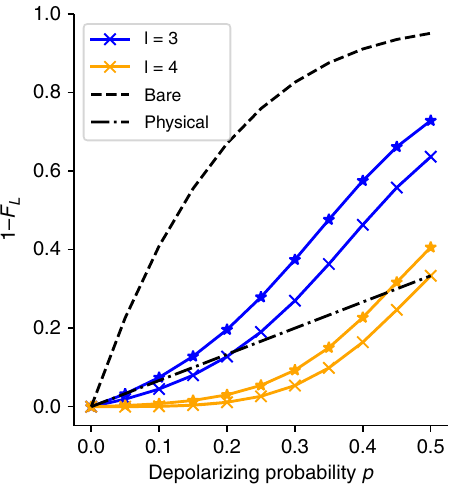
Fig. 3 Pseudo-threshold crossover for recovery using the [[5, 1, 3]] code. The model examines the impact of errors under an uncorrelated depolarizing channel showing a p ≈ 0.50 pseudo threshold for the full correction procedure. We plot the logical in fi delity 1 − ; F L where F L is the logical fi delity of a selected state in the code space of the [[5, 1, 3]] code as a function of the depolarizing probability for each qubit p . The label l denotes the number of products from the stabilizer generators used in the expansion operator set. The physical line depicts the same error if the logical state is encoded in a single qubit in the standard way. The “ bare'' line indicates the logical error rate with no recovery procedure applied. The starred lines close to each level of the hierarchy show an approximation to that level of projection using the QSE projection with 2 less check operators to demonstrate the smooth performance of the subspace